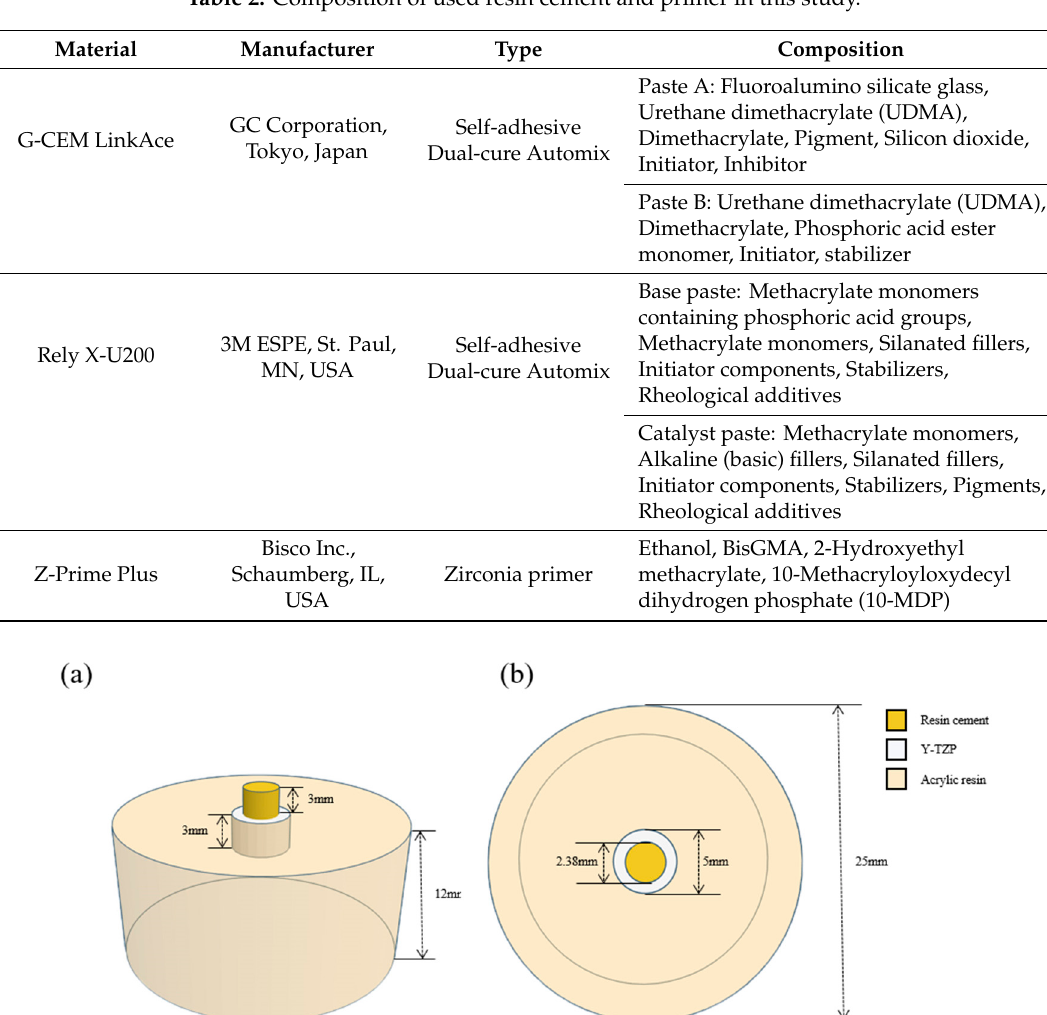
Table 2. Composition of used resin cement and primer in this study.